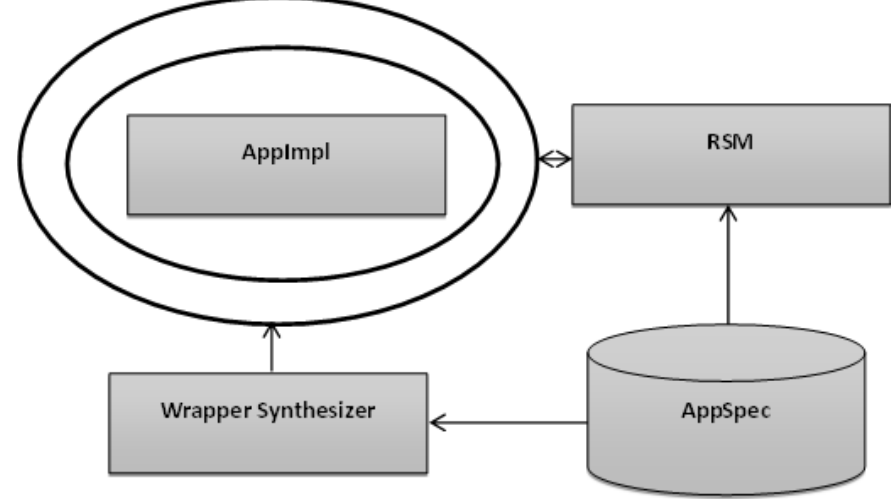
Figure 1. ARMET—Run-time security